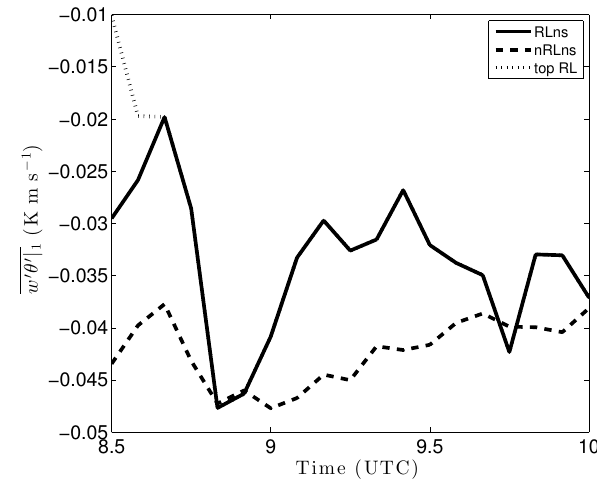
Fig.6. TemporalevolutionduringthemorningoftheentrainmentheatfluxfortheRLns(solidline),theentrainmentheatfluxatthetopof Fig. 6. Temporal evolution during the morning of the entrainment theRL(pointedline),nRLns(dashedline)DALESnumericalexperiments. heat flux for the RLns (solid line), the entrainment heat flux at the top of the RL (pointed line) and nRLns (dashed line) DALES nu- merical